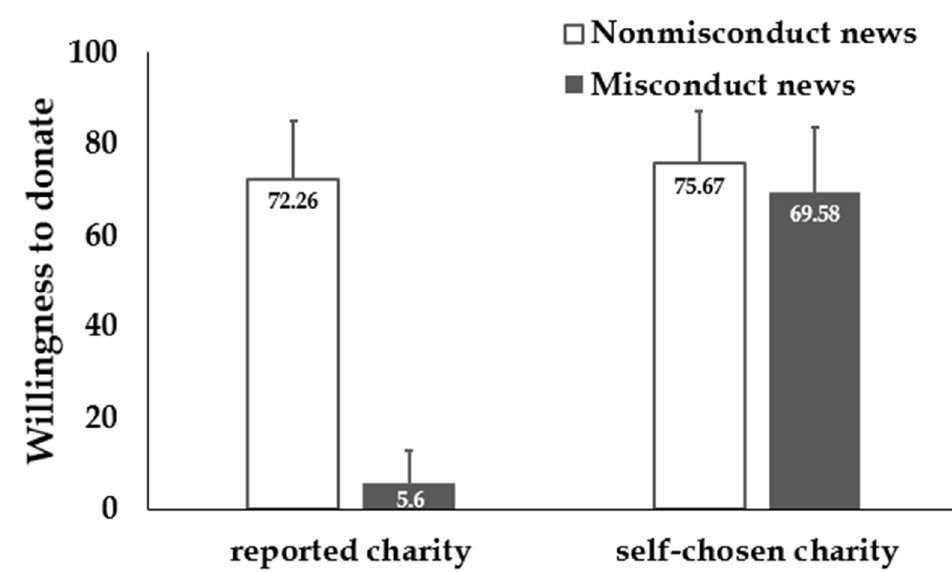
Figure 3. Results in Study 2. Willingness to donate to the reported charity and a self-chosen charity is significantly lower in participants who read charity misconduct news than those who read charity nonmisconduct news. Error bars: SD.